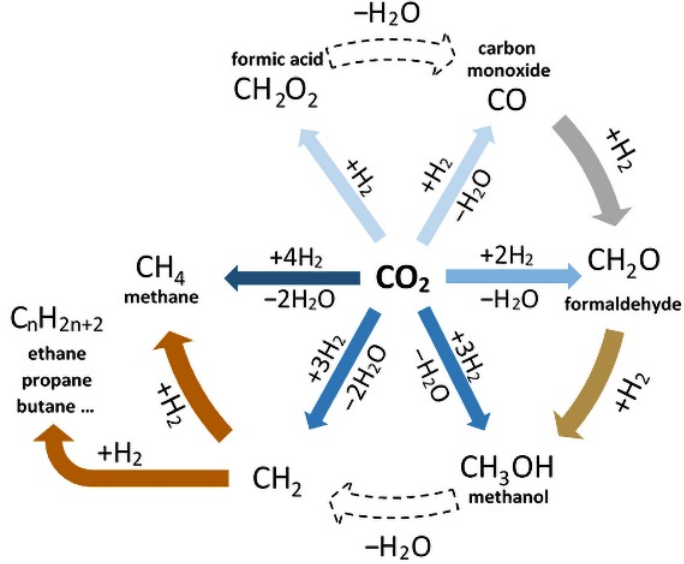
Figure 1. Main possible products of catalytic electrochemical reduction of CO 2 in an aquatic envi- ronment.